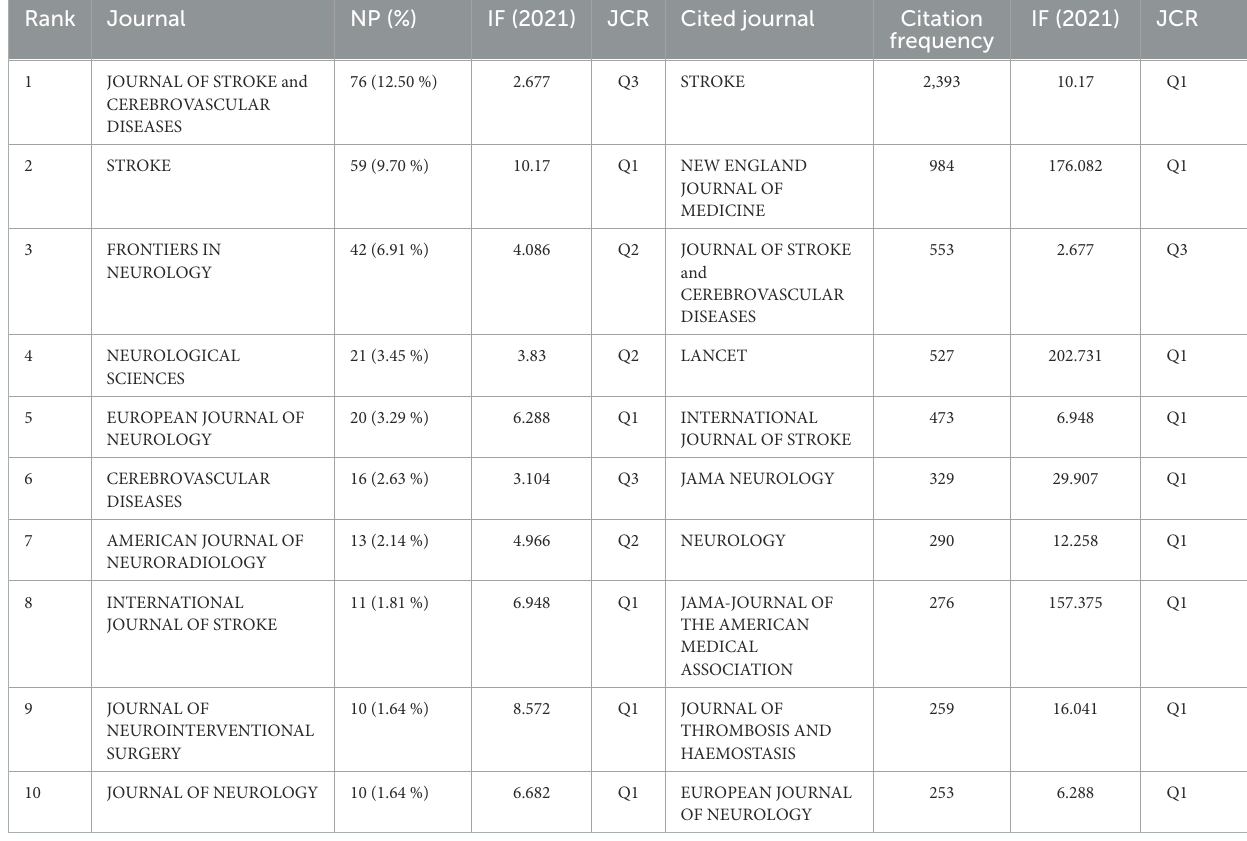
TABLE 1 Top 10 productive and most-cited journals in COVID-19 and stroke research.